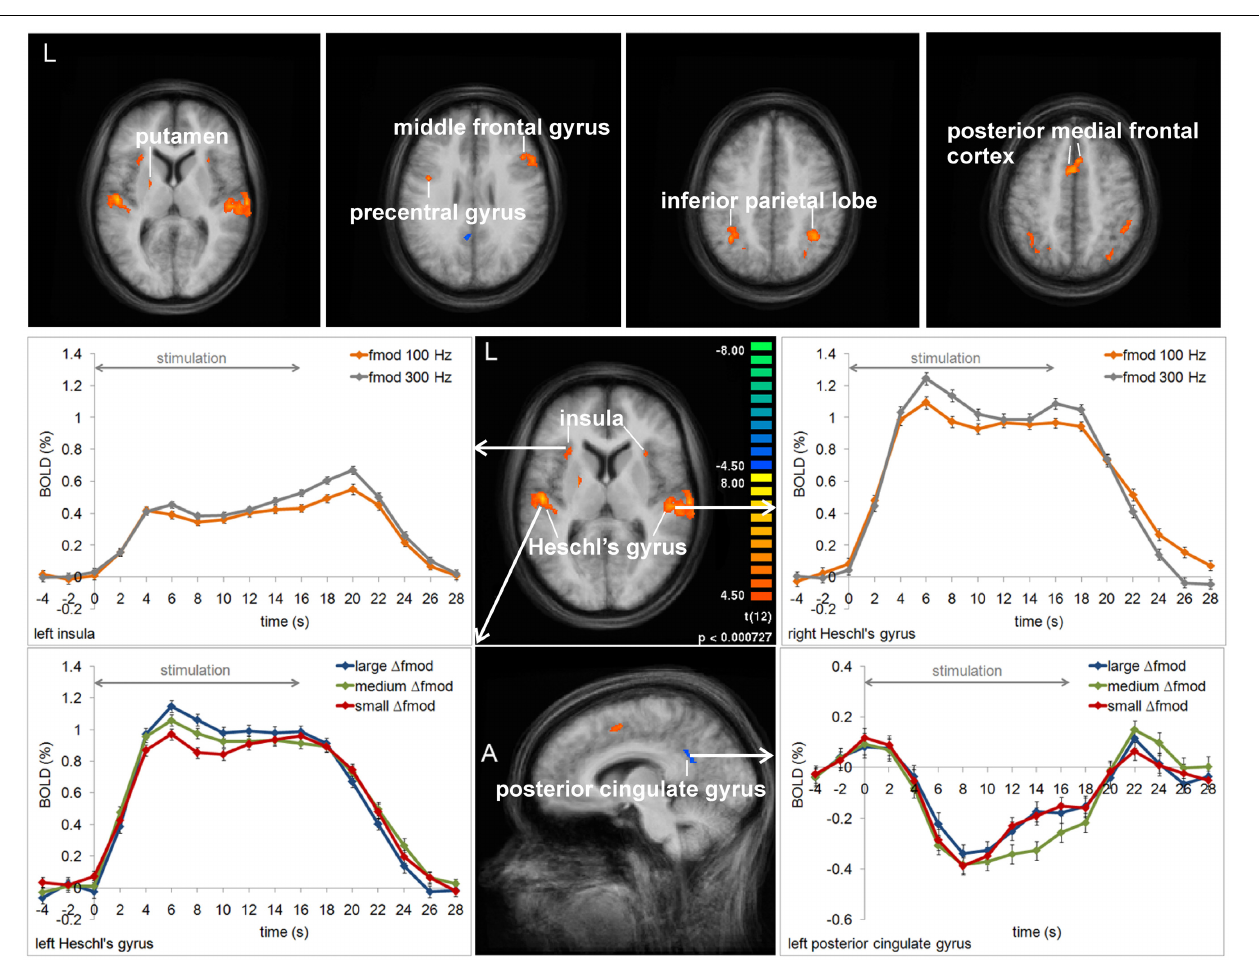
FIGURE 5 | Group average activation maps (13 subjects) and BOLD signal time courses within regions of interest in Experiment 1. The maps depict all brain regions showing positive or negative deflections of the BOLD signal in at least one of the three (cid:2) f mod conditions compared to the baseline